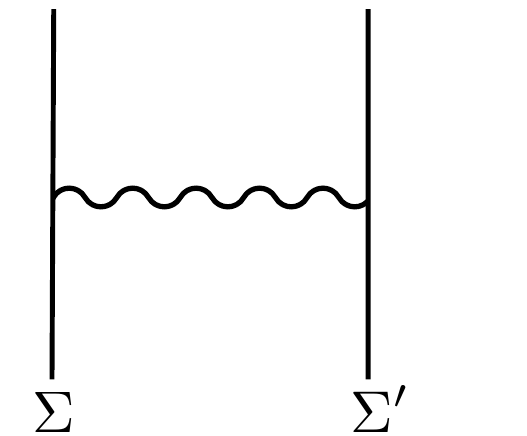
Figure 4 . Exchange of an anti-chiral two-form between two membranes wrapped on Riemann surfaces (cid:6) and (cid:6) 0